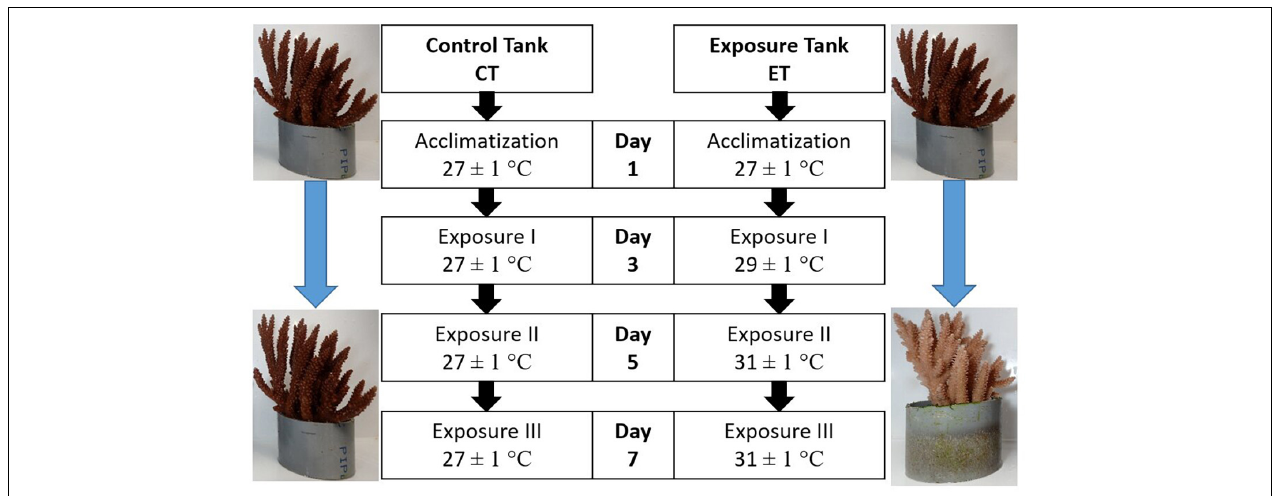
FIGURE 3 | Experimental design for control tank (CT) and exposure tank (ET). Samples were collected after 10 days of acclimatization and regarded as Day1, Day 3, Day 5, and Day 7. Both tanks were sampled at the same time.